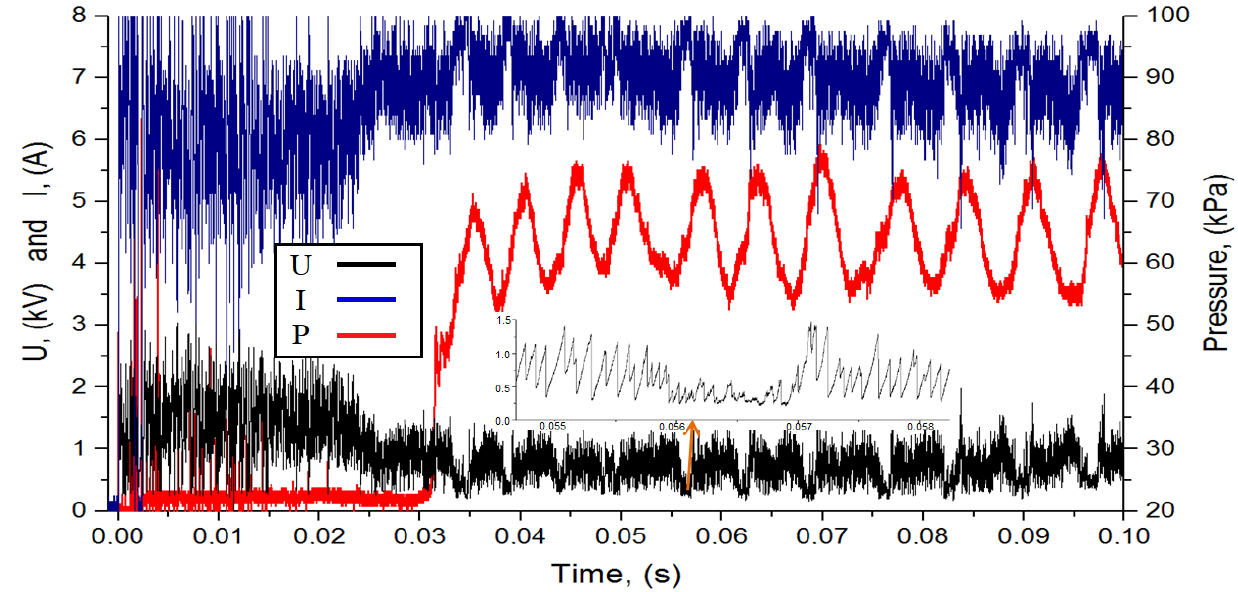
Figure 10. Oscillogram of the current and voltage of the discharge, as well as the pressure in the region of the flame front.